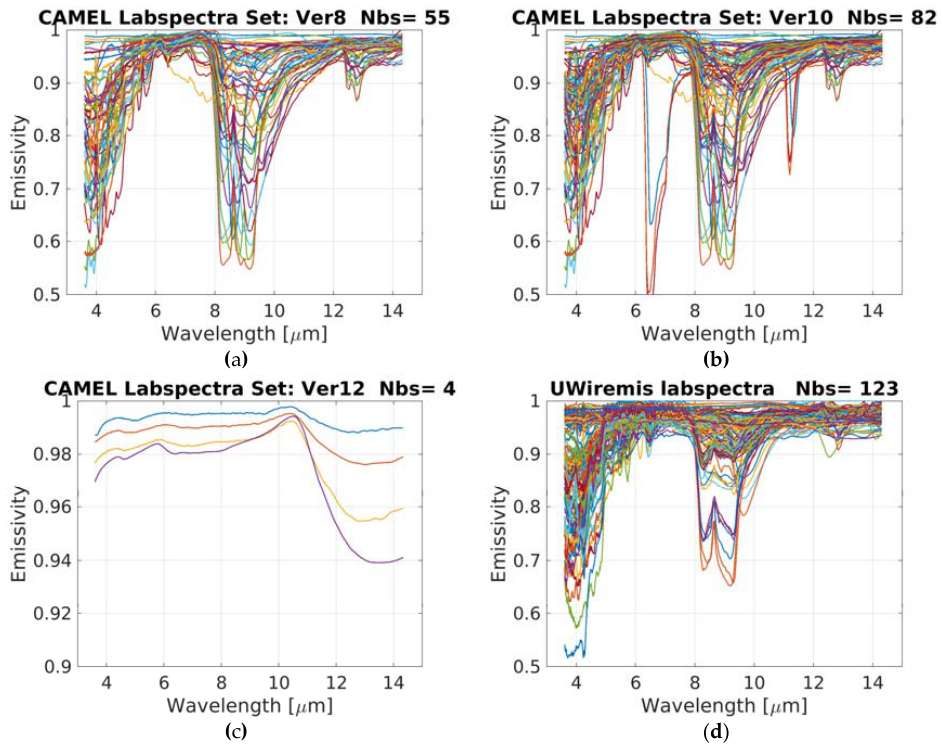
Figure 5. The CAMEL high spectral resolution (HSR) emissivity algorithm now includes three sets of laboratory spectra: ( a ) 55 selected spectra for general use (called version 8), ( b ) 82 spectra for surface types including carbonates (called version 10; version 8 + carbonates), and ( c ) four snow/ice selected spectra (version 12). The UW HSR 123 selected laboratory measurements ( d ) are shown for